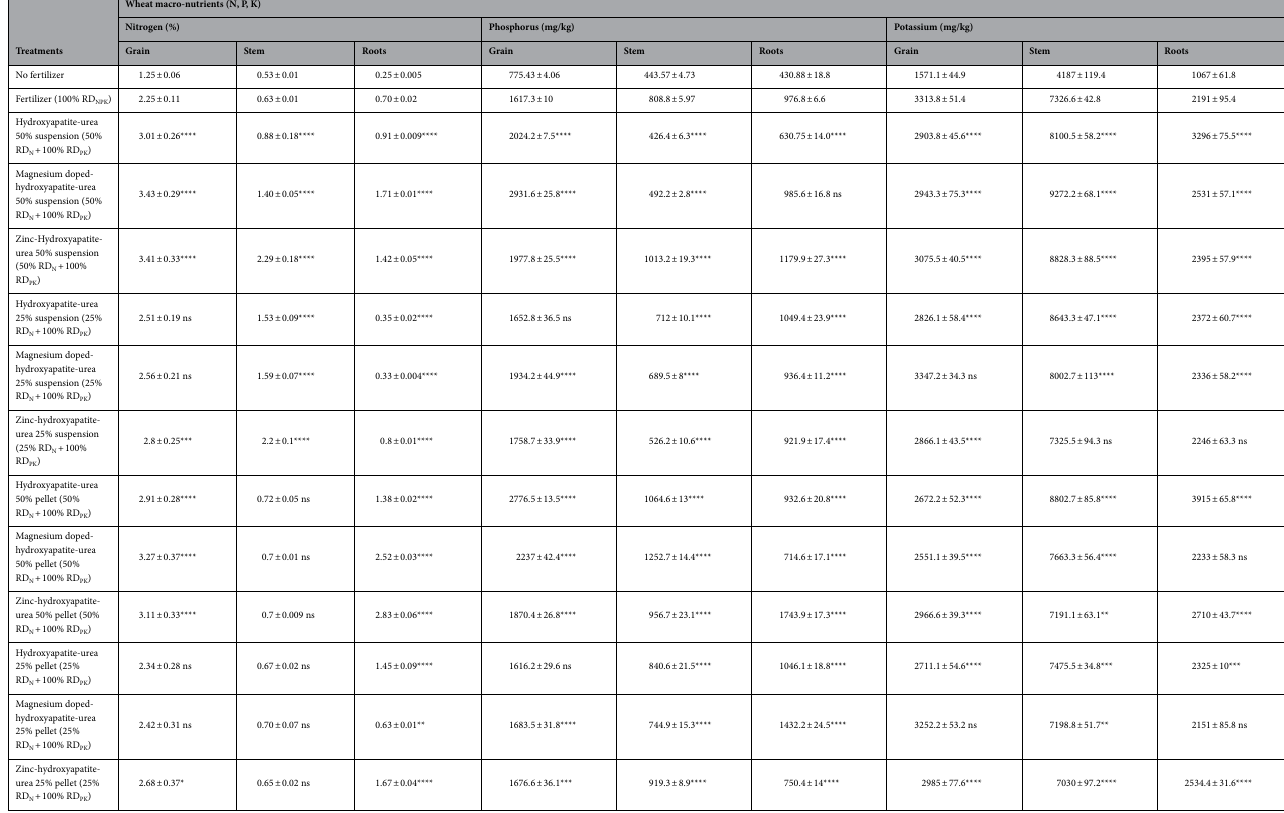
Table 1. Macro-nutrients (N, P, K) composition in nanohybrids treated wheat plants. The levels of nutritional elements (nitrogen, phosphorus, potassium) in the wheat stem, and root tissues after harvesting of the wheat crop treated with a quarter and half dose of nitrogen as nanohybrids (suspension and pellet), full dose of nitrogen as urea (as control), and without fertilizer (No Fertilizer). The values are provided as mean ± standard deviation, and statistical significance was calculated by one-way ANOVA with Dunnett’s multiple comparison test. The letters ‘*’, ‘**’, ‘***’, and ‘****’ represent ‘p < 0.05’, ‘p < 0.01’, ‘p < 0.001’, and ‘p < 0.0001’, respectively and ‘ns’ represents ‘not